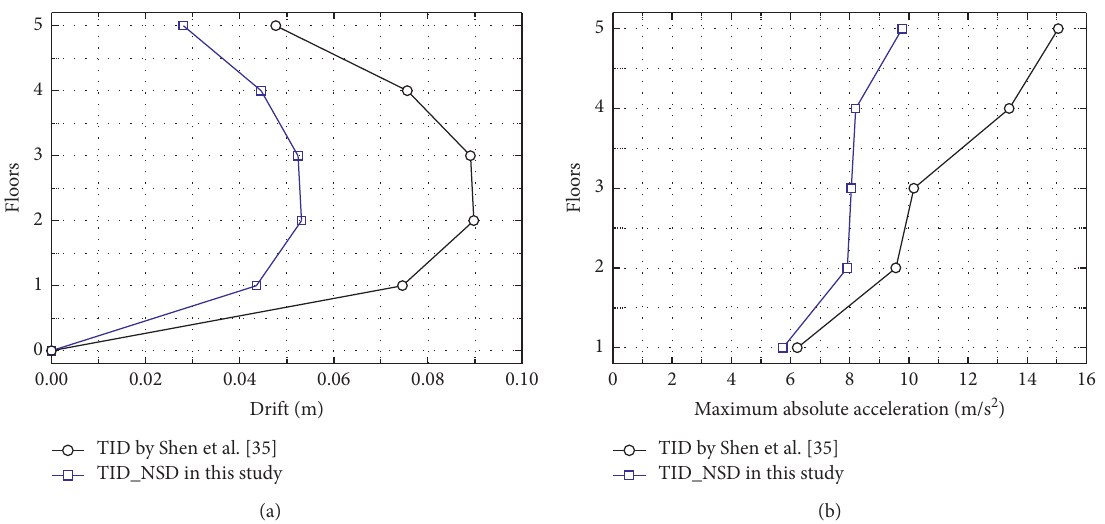
Figure 8: Maximum absolute interstorey drifts and absolute accelerations of the case study building subjected to LA04 earthquake